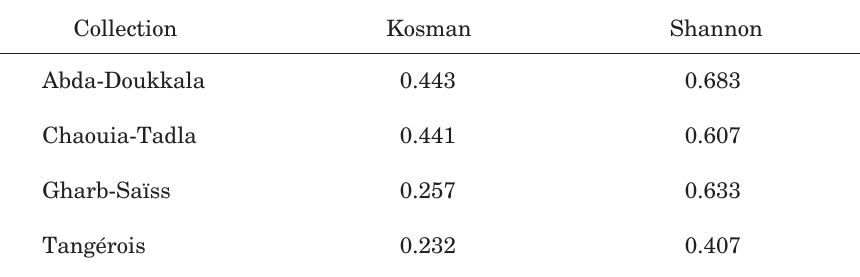
Table 3. Shannon and Kosman measures of phenotypic diversity of four collections of Puccinia recondita in Morocco during 2005 and